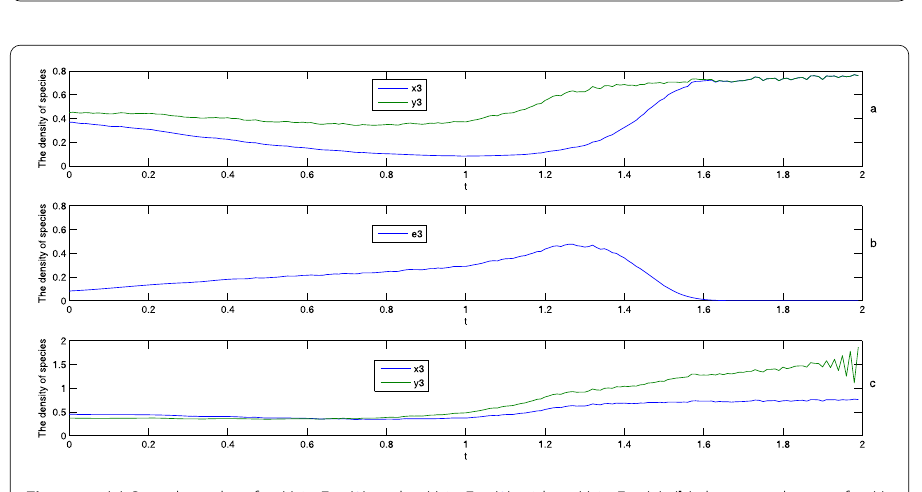
Figure 4 ( a ) Sample paths of x 3 ( t ) in Eq. (2) and y 3 ( t ) in Eq. (3) with u 3 ( t ) in Eq. (4); ( b ) the control error of x 3 ( t ) and y